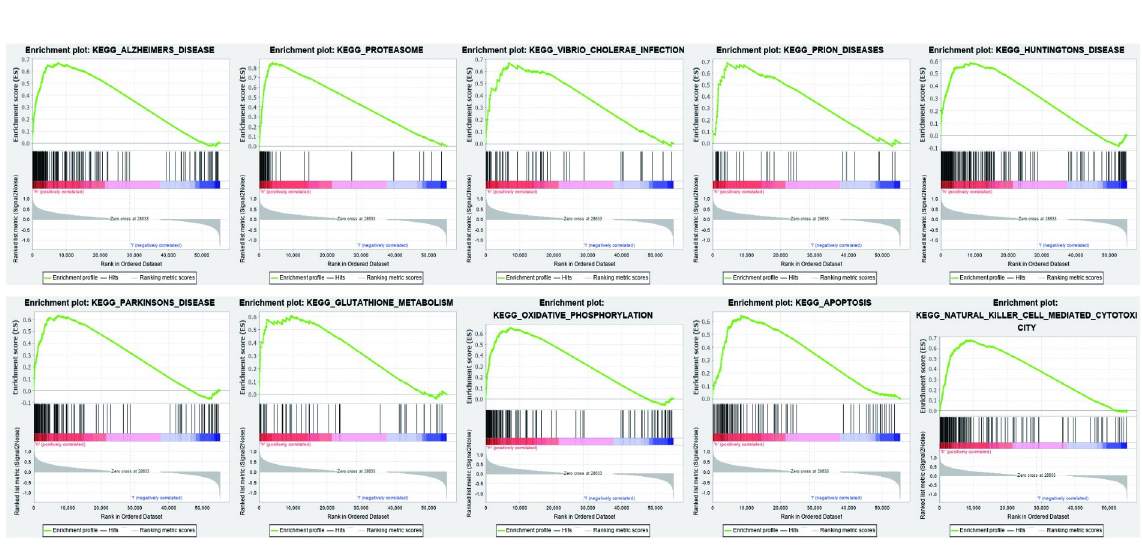
Fig 7. The GSEA analysis based on CARD11 expression. The results revealed that some pathways were enriched in UVM patients with CARD11 high expression, including Alzheimer’s Disease, Proteasome, Vibrio cholerae infection, and Prion Diseases pathways.